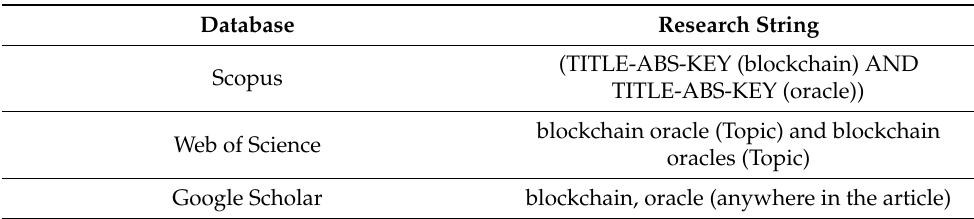
Table 1. Databases and Research